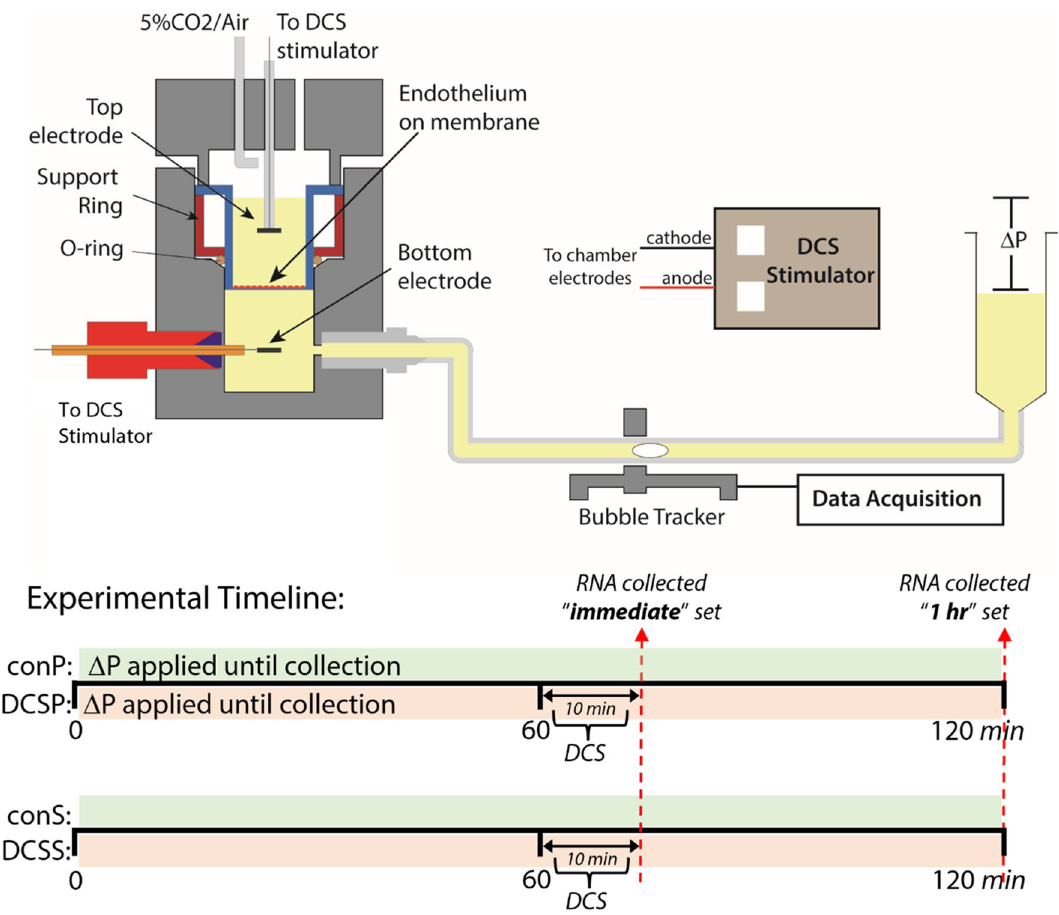
Figure 1. Top: Transport system used to apply direct current stimulation (DCS) to cell monolayers. Transwell filters containing the cell monolayer were sealed inside the chamber. Water flux was measured, via the automated bubble tracker, after the application of a 10 cm H 2 O hydrostatic pressure differential (ΔP). Cell monolayers were stimulated with 0.1–1 mA current for 10 min using a transcranial Direct Current Stimulator. Bottom: Timeline of ΔP and DCS application, and RNA collection, for each experimental group. Note that in the “immediate” collection set of samples, conP and DCSP groups are exposed to ~ 1 h of ΔP, whereas in the “1 h” collection set, conP and DCSP groups are exposed to ~ 2 h if ΔP. Top figure was modified from Sci. Rep. 8, 1–13